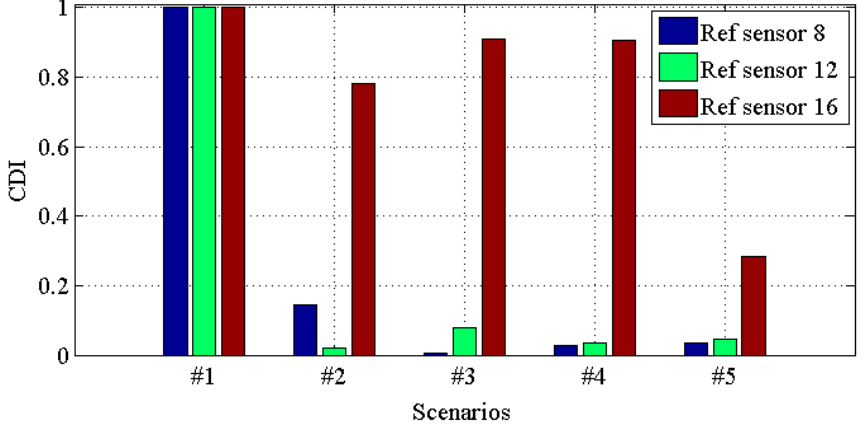
15 for damage scenario #1 to #5. Materials 2017 , 10 , 866